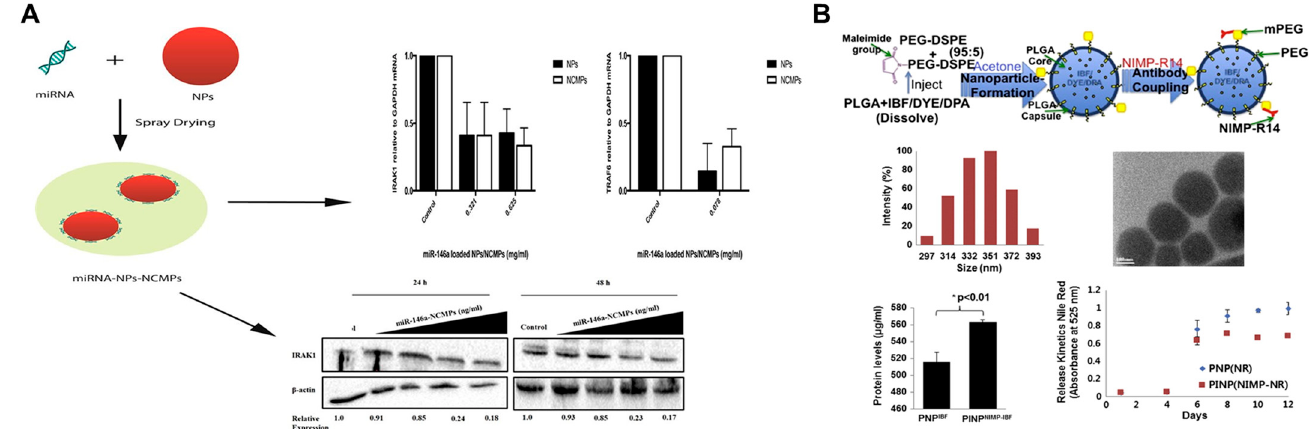
Figure 3. ( A ) Pulmonary delivery of nanocomposite microparticles (NCMPs) incorporating miR-146a for treatment of COPD. Reproduced with permission from [134]. ( B ) Synthesis, characterization, and kinetics of neutrophil-targeted and drug/dye-loaded nanoparticles (PINPNIMP-IBF). Reproduced with permission from [135].